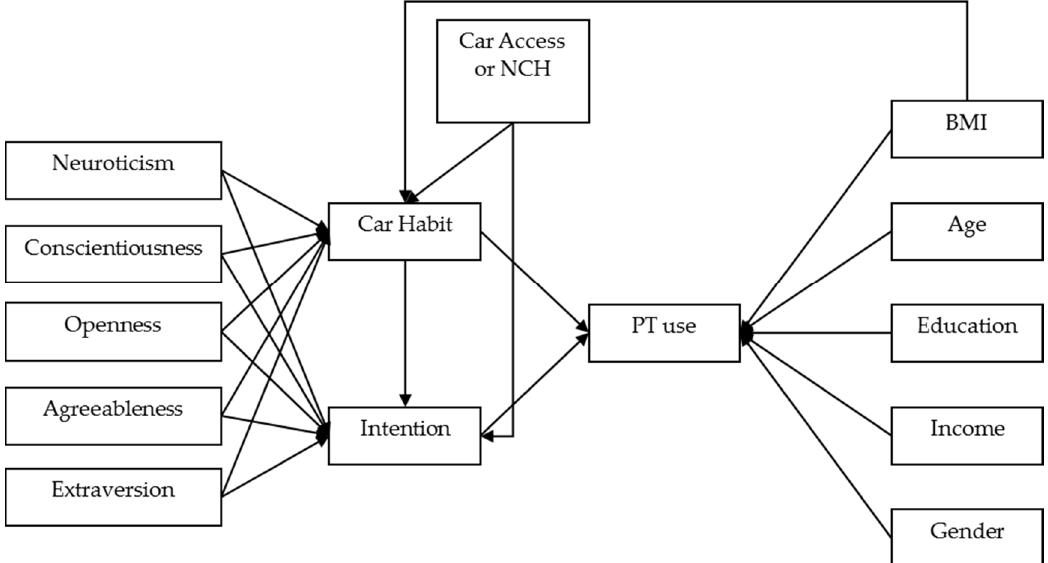
Figure 1. The proposed path model for determining the influence of personality traits through car habit and intention toward public usage on the preference of the number of future public transport usage (PT use), NCH: number of cars in the household, BMI: body mass index.